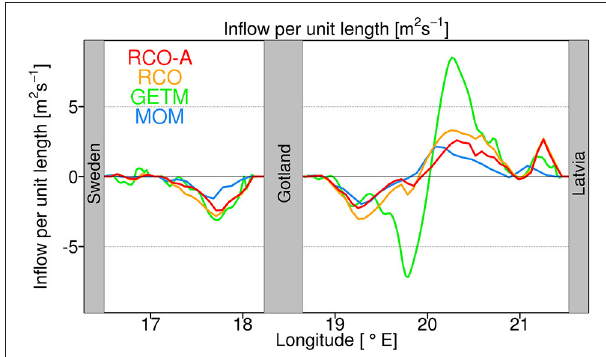
of the error owing to the rounding of numbers to thousands.